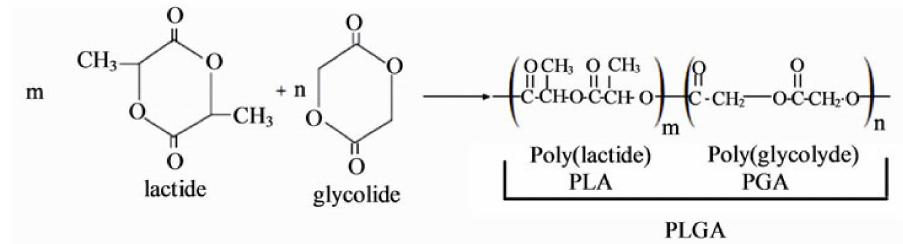
Figure 8. Chemical structure of the cyclic dimers and the copolymerization reaction (ROP) [65].